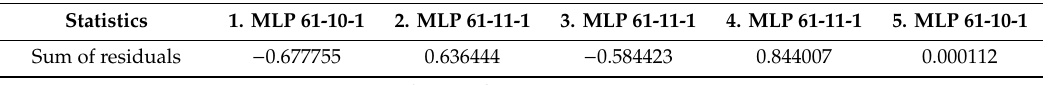
Table 9. Sum of residuals of individual equalized time series.